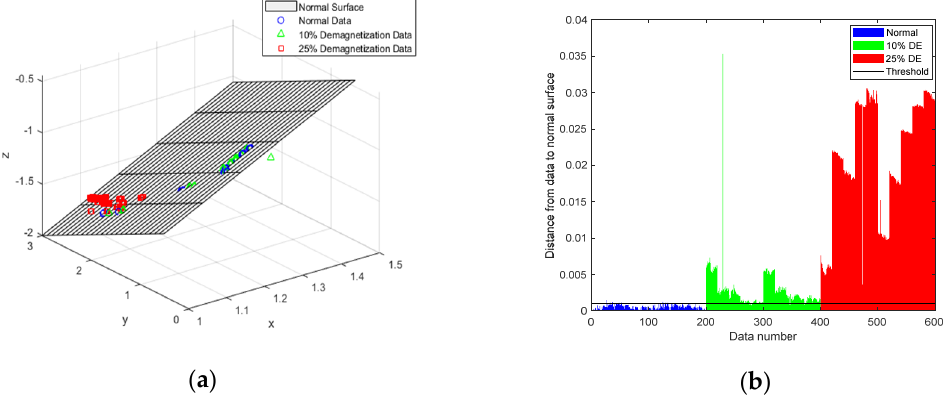
Figure 7. Three-dimensional vectors of test data. The distribution of three test PMSMs: blue circles represent data for the normal PMSM, green triangles represent data for the PMSM with 10% demagnetization fault, and red squares represent data for PMSM with 25% demagnetization fault